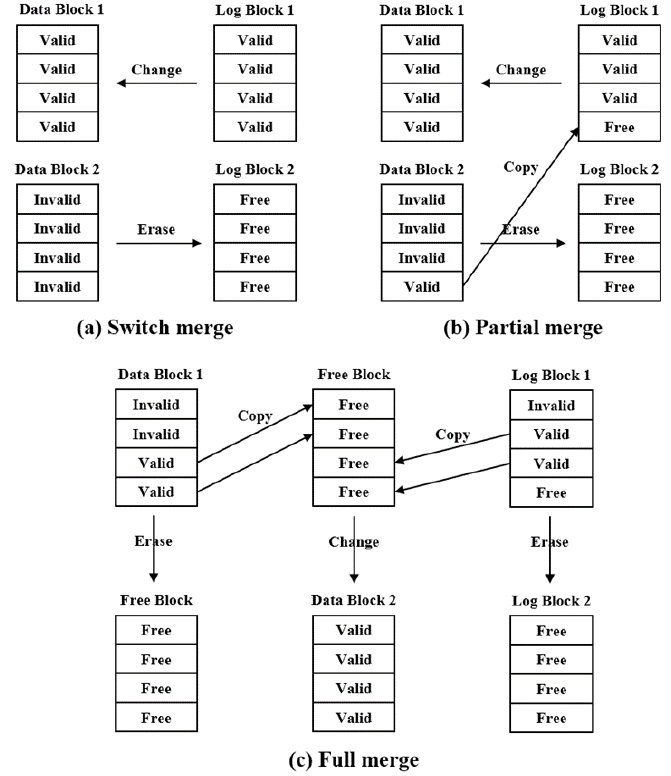
Figure 1. Three categories of operations of merge.